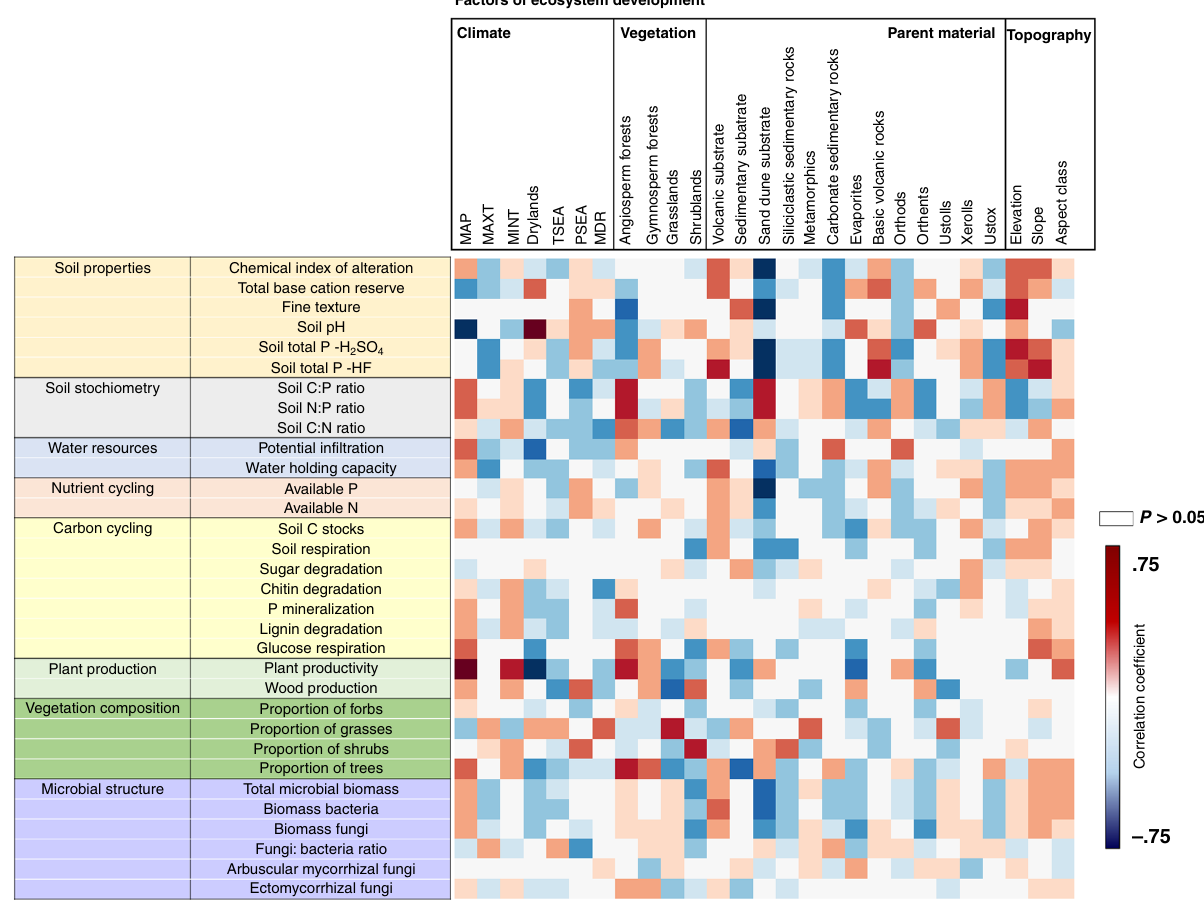
Fig. 4 Correlations between environmental factors and ecosystem properties. Partial correlations (Spearman) (see Supplementary Table 3 for the number of samples) between climate, vegetation type, parent material, and topography with ecosystem structure, and functions controlled for soil age and geographical location. See Supplementary Table 3 for a list of functional and structural properties and a rationale for their importance for terrestrial ecosystems. See Supplementary Table 4 for a list of ecosystem development factors and a rationale for their importance for terrestrial